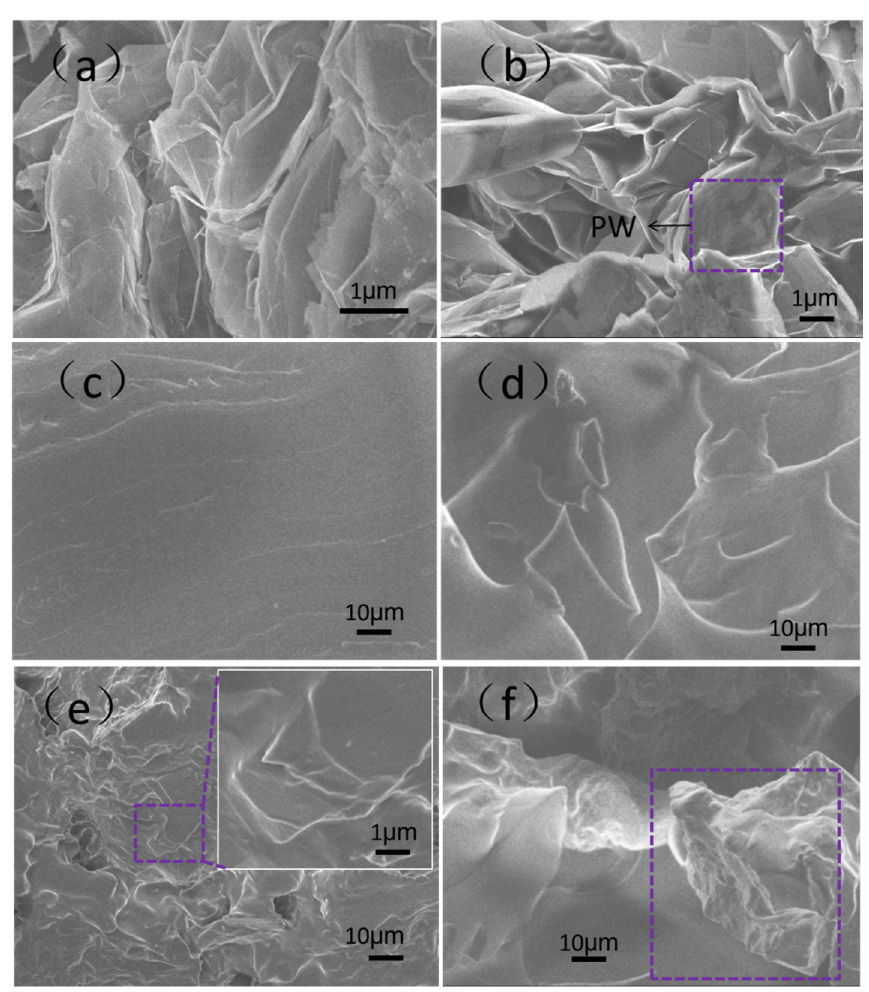
Figure 2. SEM micrographs of ( a ) EG, ( b ) EG/PW, ( c ) SR, ( d ) phase-change material (PCM)-1, ( e ) PCM-2 and ( f ) PCM-3.